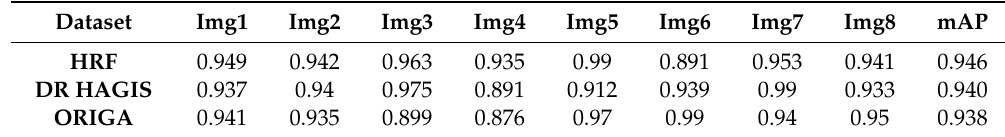
Table 4. Glaucoma